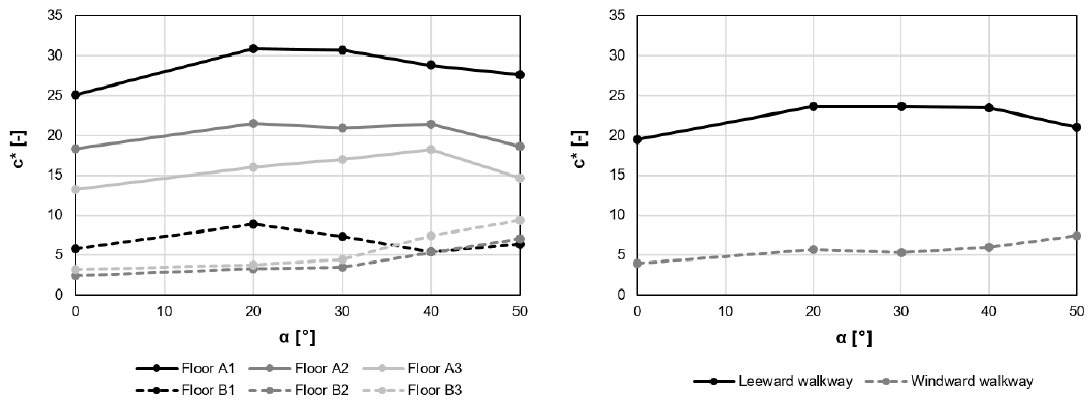
Figure 16. Left : normalized concentration at the focus areas as a function of the roof angle. Right : normalized concentration averaged on the leeward and windward walkways (6 m wide surfaces along the entire building length) as a function of the roof angle.